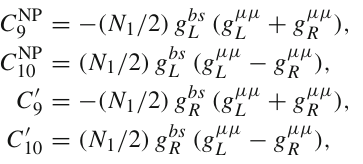
where g bs are the left-handed (right-handed) couplings of L ( R ) μμ to muons. After the Z (cid:4) boson to quarks, and g L ( R )